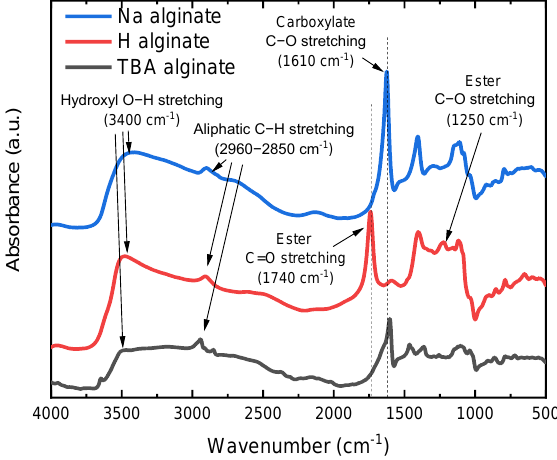
Figure 2. FTIR spectra of powders of alginic acid (H alginate), Na alginate and TBA alginate.